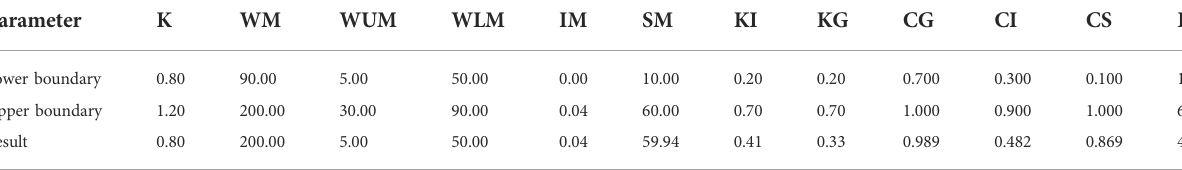
TABLE 7 Results of the two algorithms in the calibration of the XAJ model using observed data. F obj F 1 F 2 F 3 Iterations Number of SCEA CSCE